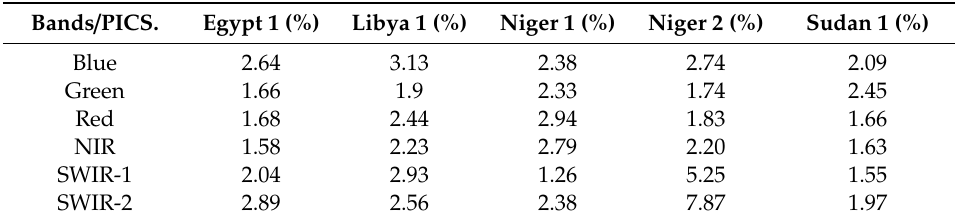
Table 5. Accuracy between model predictions and Terra MODIS observations. Bands / PICS.